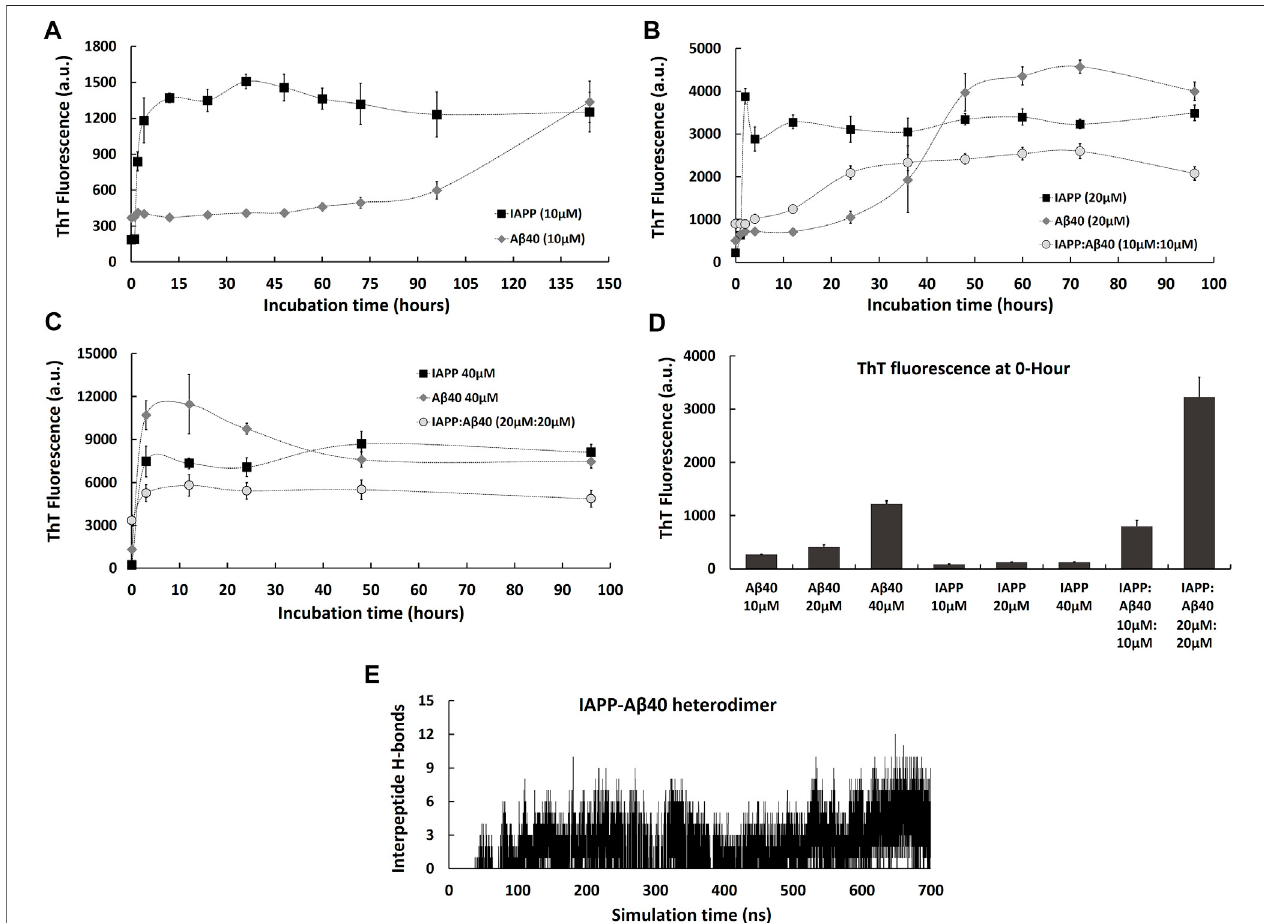
FIGURE1| Kineticpro fi lesoftheco-aggregation(IAPP-A β 40equimolarmixture)andself-aggregation(IAPPaloneandA β 40alone)pathways.Theself-aggregation pro fi les of IAPP alone and A β 40 alone were acquired at three increasing concentrations: (A) 10 µM, (B) 20 µM and (C) 40 µM. The co-aggregation pro fi les of equimolar mixture of IAPP:A β 40 were acquired at (B) 10 µM:10 µM and (C) 20 µM:20 µM. (D) ThT fl uorescence intensities of the freshly prepared samples (i.e., 0-Hour) of IAPP alone, A β 40 alone and IAPP-A β 40 at all examined concentrations. (E) Time evolution of inter-peptide hydrogen bonds formed between IAPP and A β 40 in their hetero-dimer system. All ThT fl uorescence data (a.u.) represent mean ± SE ( n =